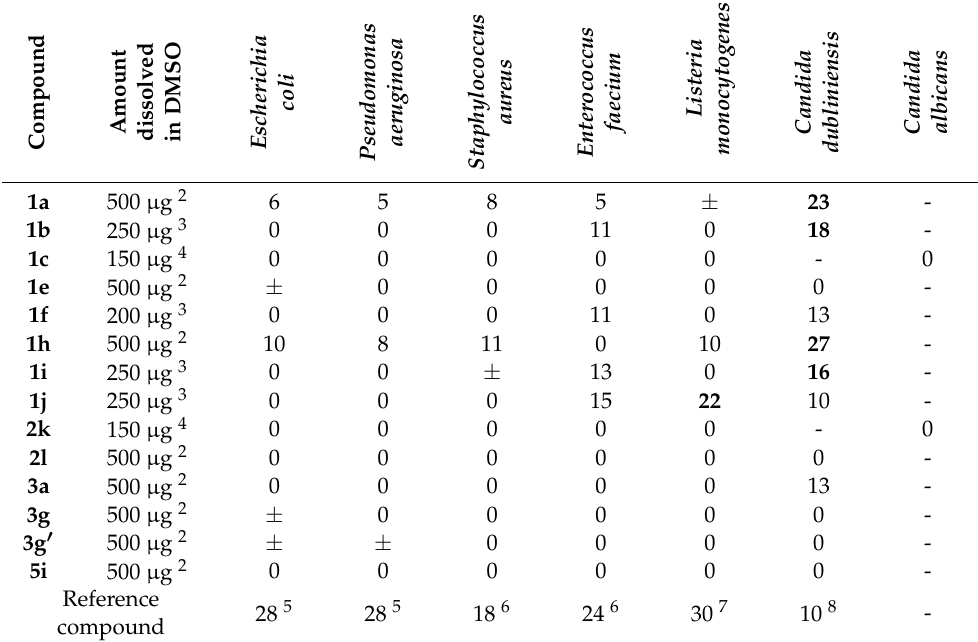
Table 5. Antimicrobial and antifungal activity 1 of some of the synthesized compounds.